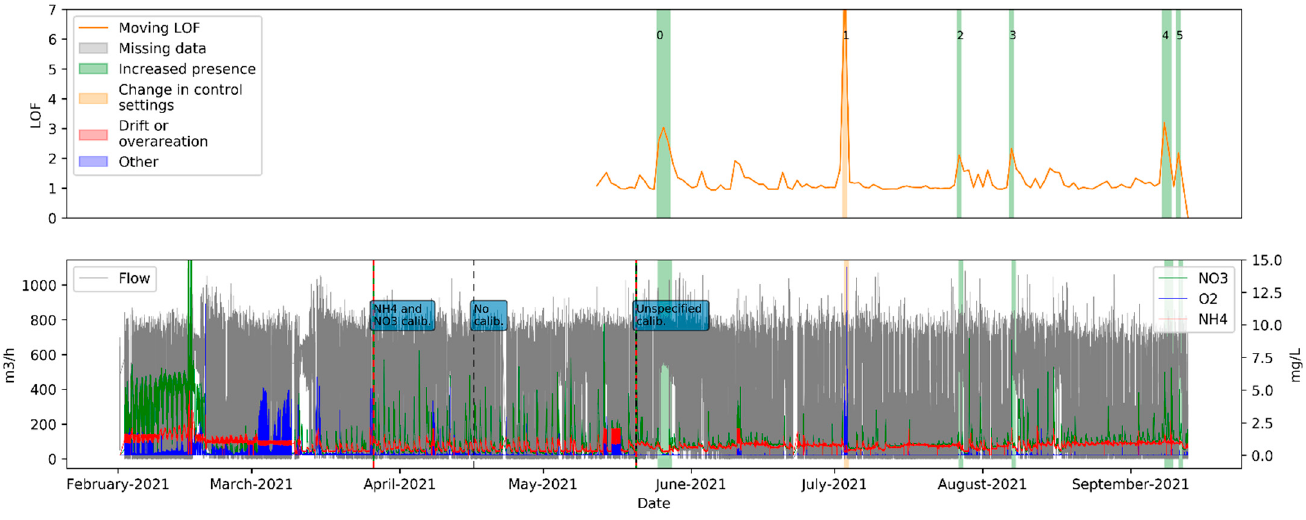
Figure 10. WWTP3 PCT1. In the upper graph the orange line shows the Moving LOF and the coloured areas, numbered from 0 to 5, show anomalies detected when the Moving LOF exceeded the threshold of two. The lower graph shows the flow, NO3, DO and NH4 and calibration data available from the plant.